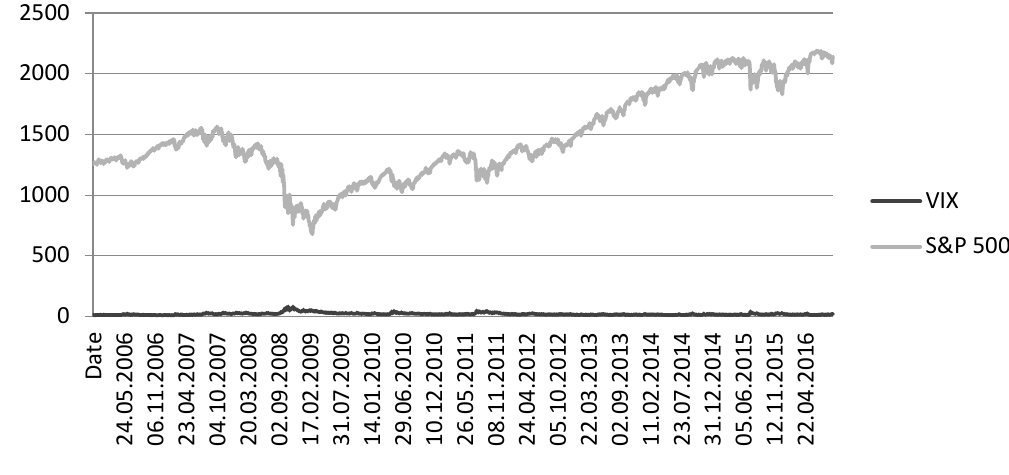
Figure 1. Evolution of S& P 500 index and implied volatility